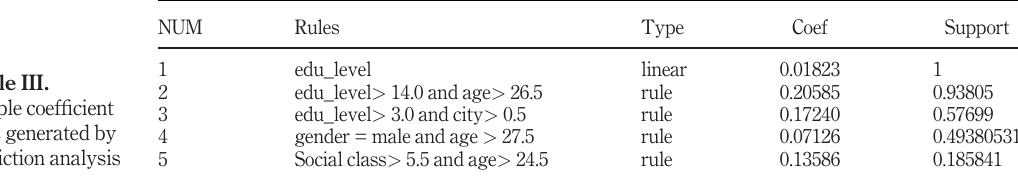
Table III. Sample coef fi cient rules generated by prediction